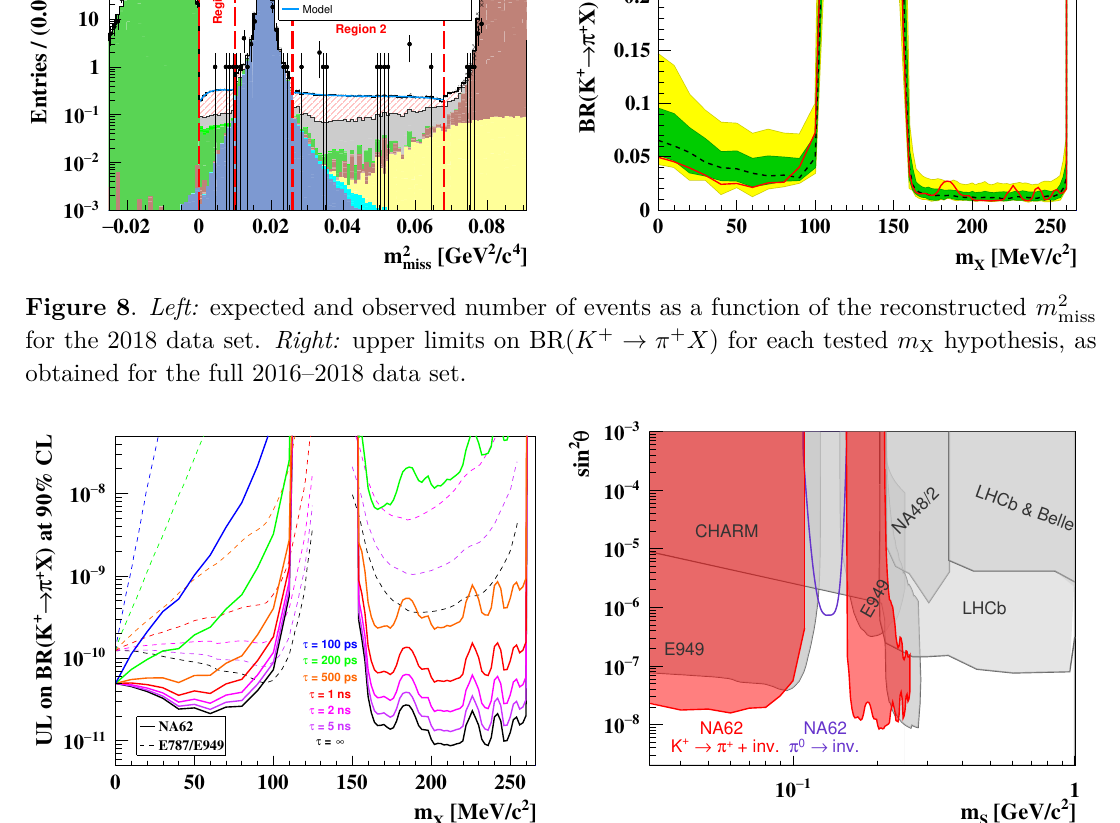
Figure 9 . Left: model-independent observed upper limits as functions of the X mass and lifetime hypotheses. Right: excluded regions of the parameter space ( m sin 2 θ ) for a dark scalar, S , of the S , BC4 model [20] decaying only to visible SM particles. Exclusion bounds from the present search for the decay K + → π + X are labelled as “ K + → π + + inv.” and are shaded in red. The constraints from the independent NA62 search for π 0 → invisible decays [34] are shown in purple. Other bounds, shown in grey, are derived from the experiments E949 [17], CHARM [37], NA48/2 [38], LHCb [39, 40] and Belle